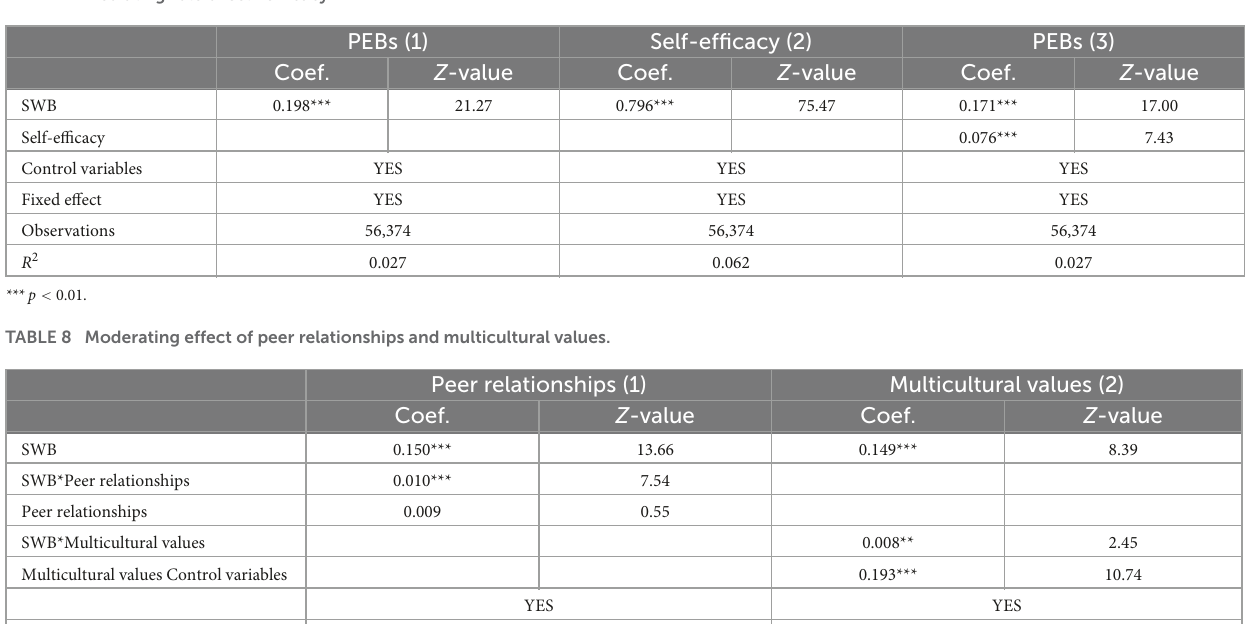
TABLE 7 Mediating role of self-efficacy.